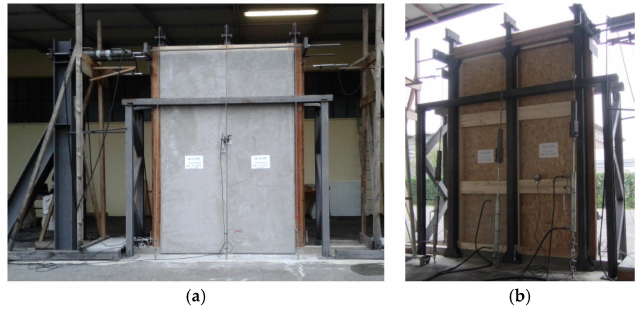
Figure 6. Experimental setup: external ( a ) and inner ( b ) views.